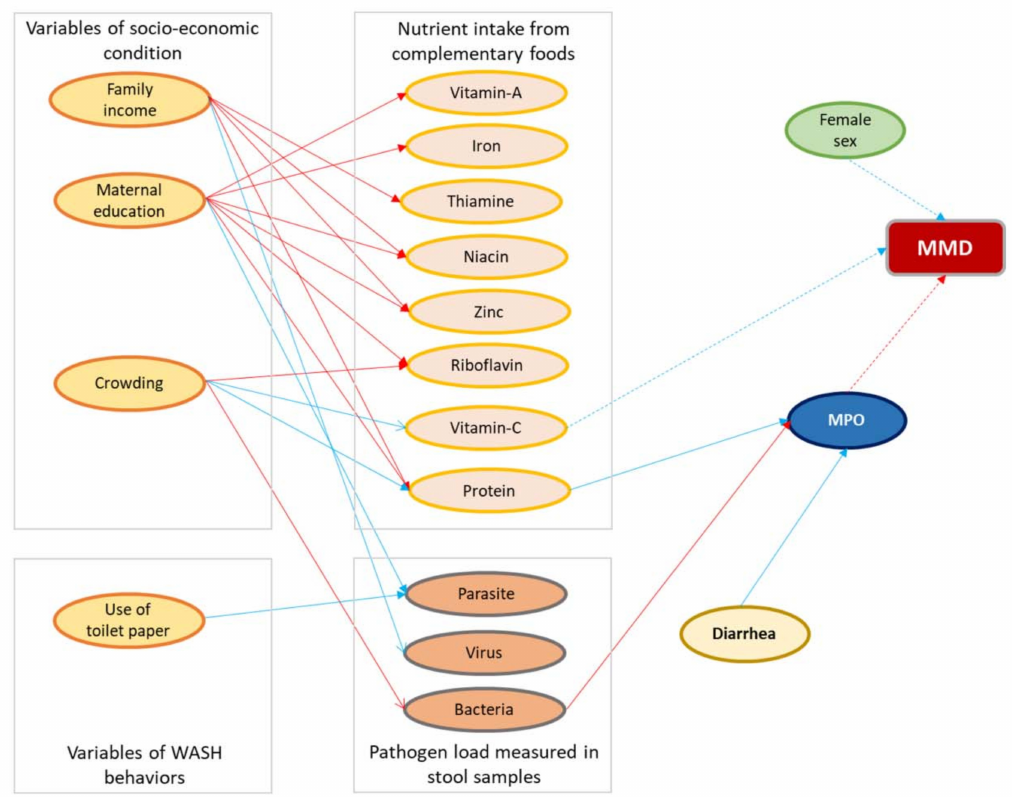
Figure 3. Results of the multivariate Bayesian network. Arcs (arrows) are shown for parameters that did not include zero in the 95th percentile credibility interval. Positive associations are shown in red and negative in blue. The arcs with solid lines indicate linear associations and dashed lines indicate log odds. MPO, myeloperoxidase; MMD, multiple micronutrient